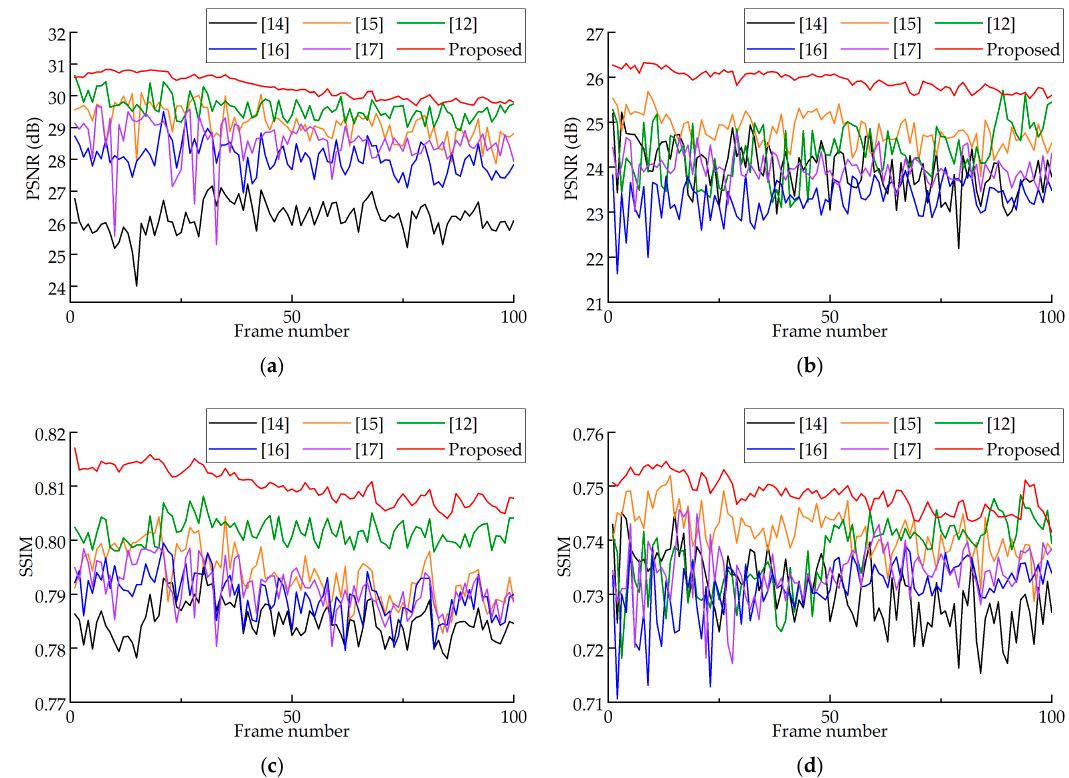
Figure 14. Objective comparison results: ( a ) PSNR of BA54; ( b ) PSNR of BA52; ( c ) SSIM of BA54; and ( d ) SSIM of